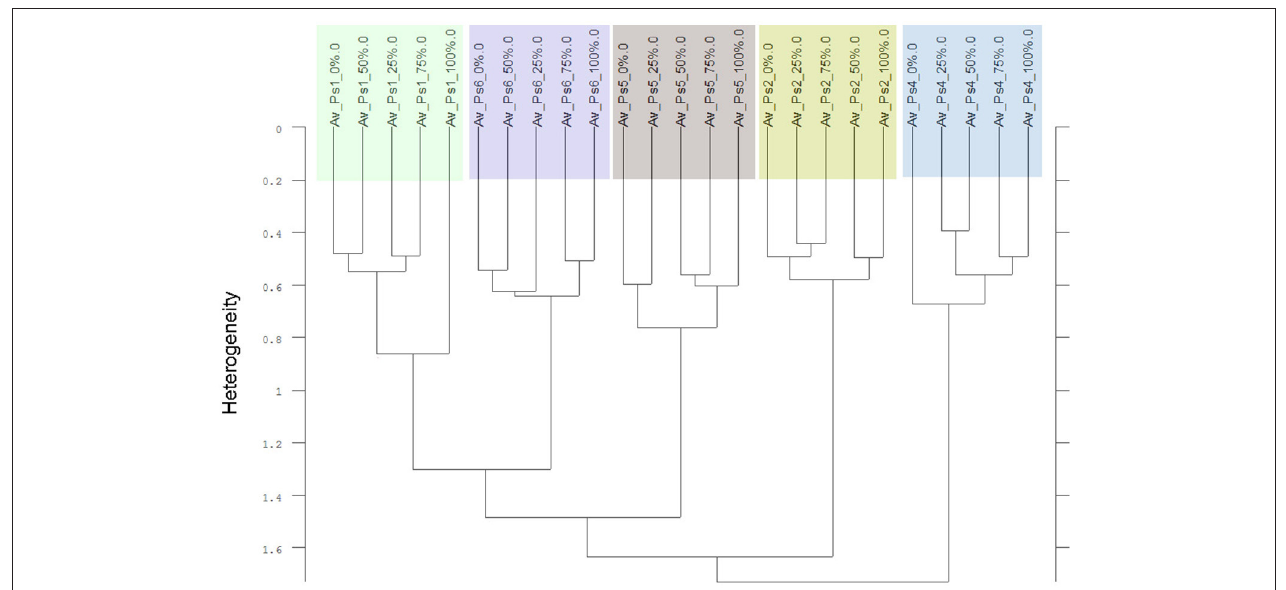
FIGURE 8 | Cluster analysis of the Av-spectra of five of the six cultivars of the species Pisum sativum (Ps, pea) of the experiment 1-1, omission of cultivar 3 (Ps3). Complete frequency range (3,997–374 cm − 1 ) of the Av-spectra was evaluated with the second derivation and vector normalization, Ward’s algorithm und Euclidian distance. The Av-spectra are averages (Av) of FTIR-ATR spectra of the different root segments (100% root tip, 0% root basis etc.; see Figure 1 for scheme, Table 2 for n, Table 1 for names of cultivars and proveniences).